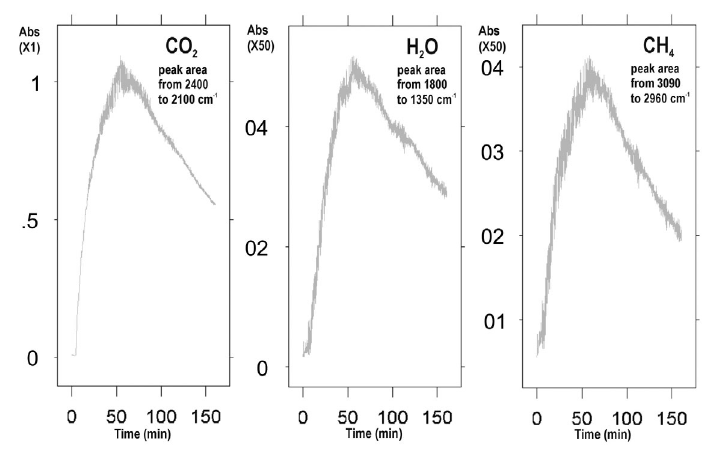
Fig. 3. FTIR Gas analysis: CO 2 , H 2 O, CH 4 emissions during milling (1 g sample, 180 min